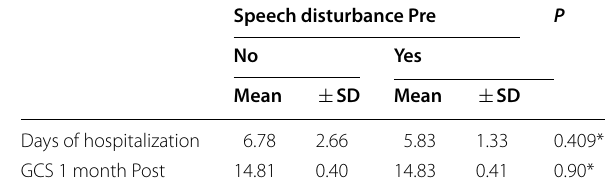
Table 10 Cases with and without preoperative speech disturbance compared regarding final study